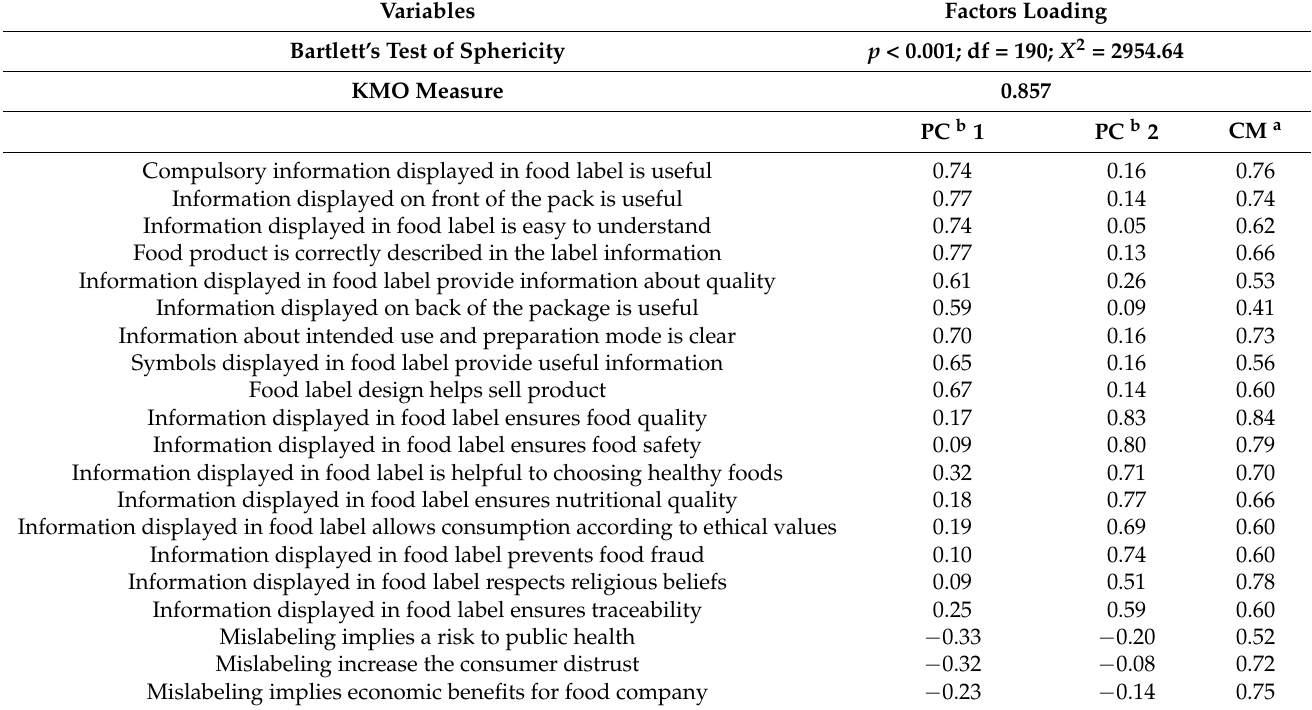
Table 4. Factor loadings and communalities of variables in the first two components (PC1 and PC2) after varimax normalized